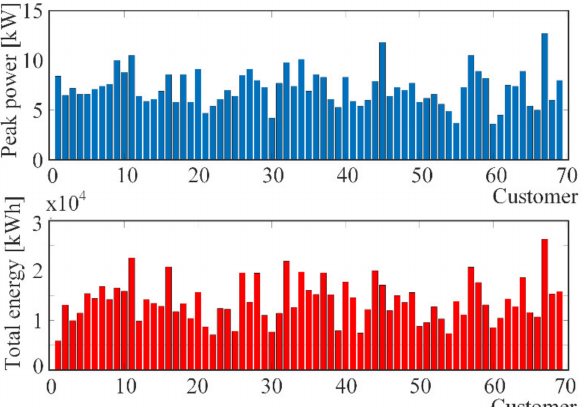
Figure 4. The power peak and the total power consumption of the residential area under examination for each customer from 1 March 2018 to 28 February 2019.